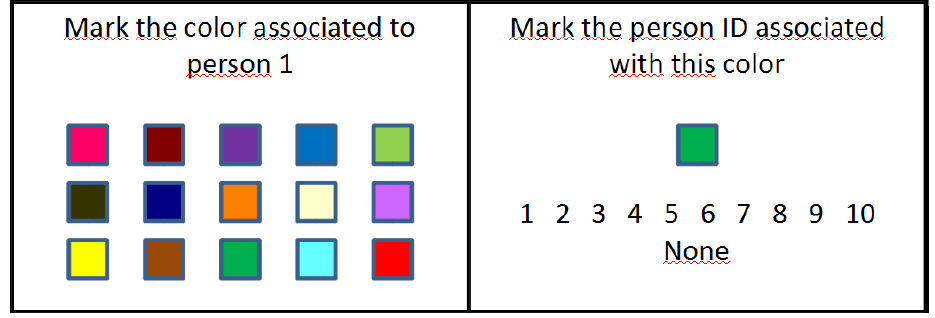
Figure 6. Examples of the question cards used in the person-color association